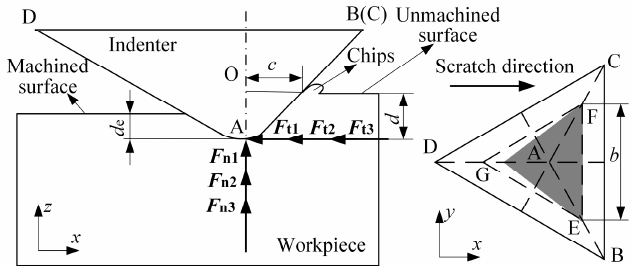
Figure 2. Force analysis model in the ductility leading stage.